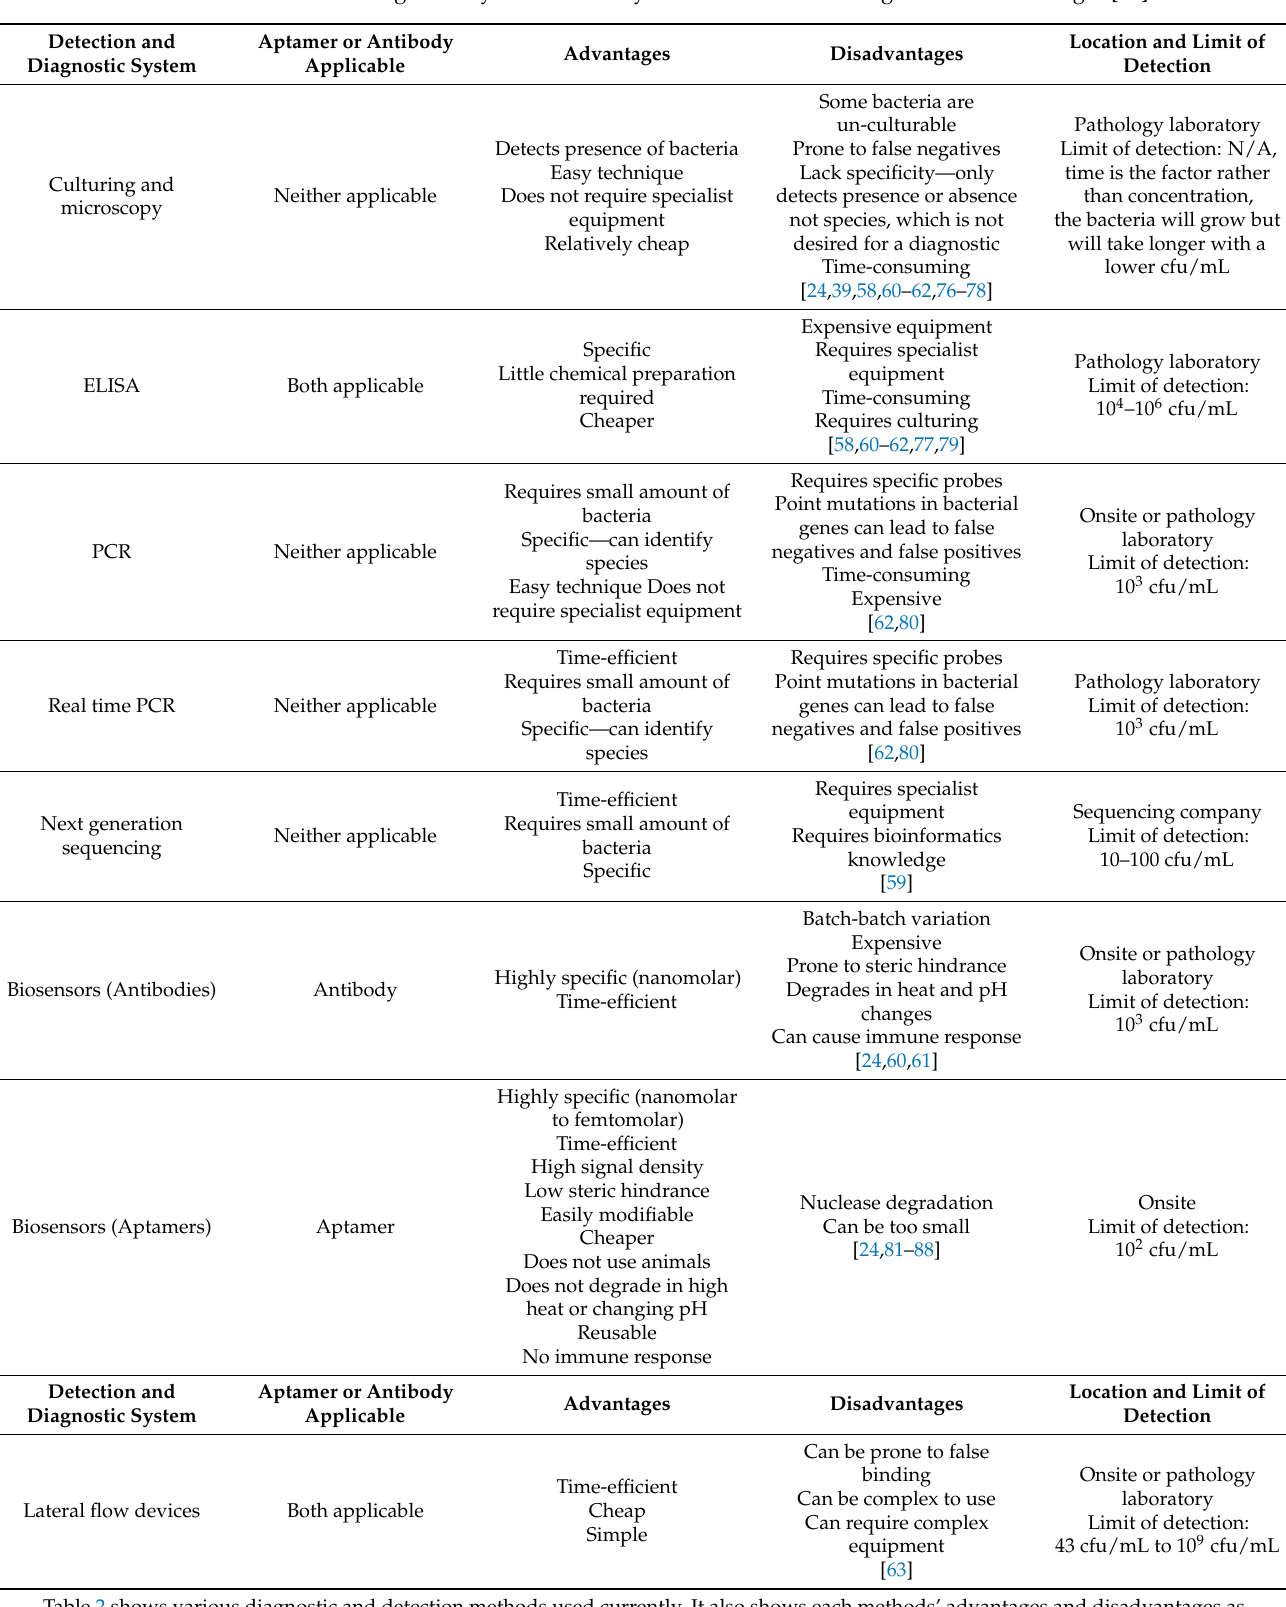
Table 2. Detection and diagnostic systems currently used and their advantages and disadvantages